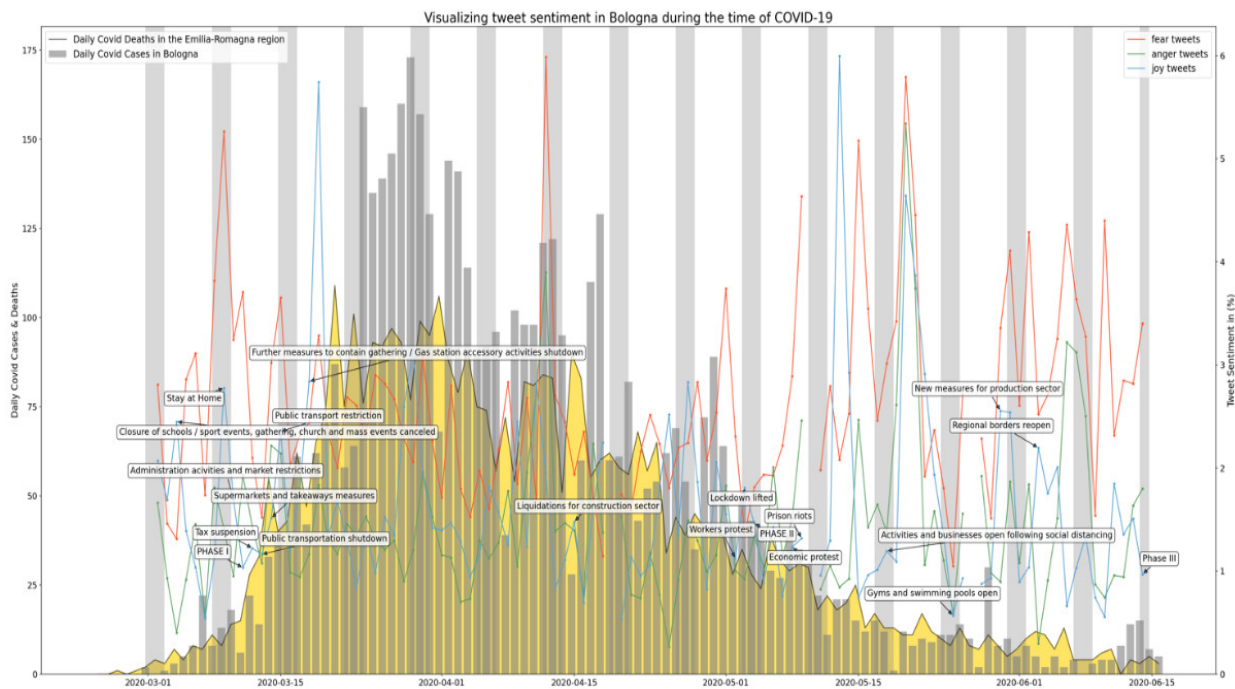
Figure A4. Visualizing Twitter sentiment in Bologna during the time of COVID-19.